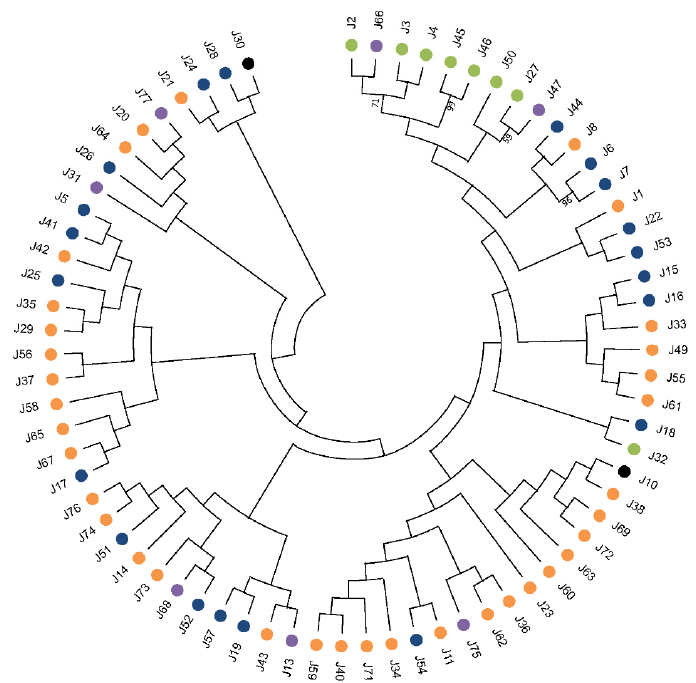
Figure 3. Phylogenetic relationships among L. infantum HSP40 proteins. The evolutionary history was inferred by using the Maximum Likelihood method and JTT matrix-based model [35]. The tree with the highest log likelihood (-96100,93) is shown. Initial tree(s) for the heuristic search were obtained automatically by applying Neighbor-Join and BioNJ algorithms to a matrix of pairwise distances estimated using the JTT model, and then selecting the topology with superior log likelihood value. This analysis involved 72 amino acid sequences, and the tree was inferred from 1000 replicates. There were a total of 2470 positions in the final dataset. Bootstrap values lower than 50% are not indicated. Evolutionary analyses were conducted in MEGA11 [36]. Color codes denote the HSP40 classification: type I (green), type II (blue), type III (orange), type IV (violet), not applicable (black). Table 1. L. infantum HSP40 proteins.